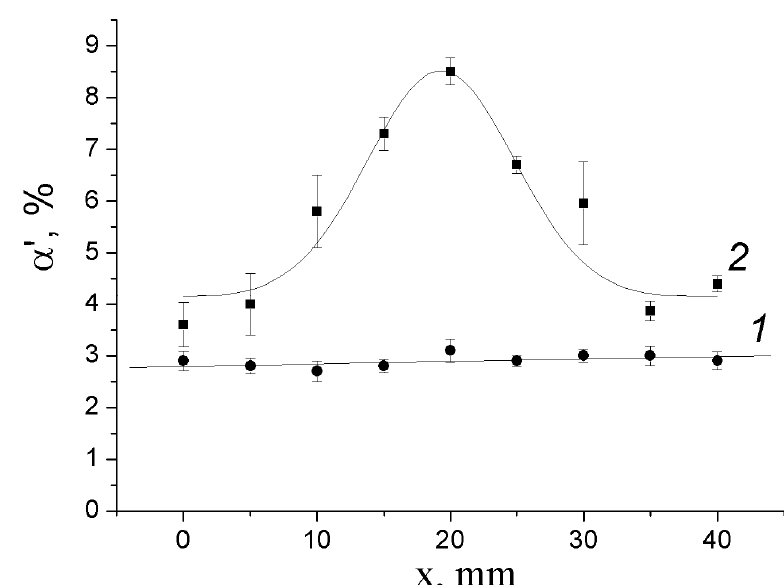
Figure 5. Martensite distribution before ( 1 ) and after ( 2 ) deformation in the pseudo-plateau region (state 2 , time point t 6 after specimen unloading).